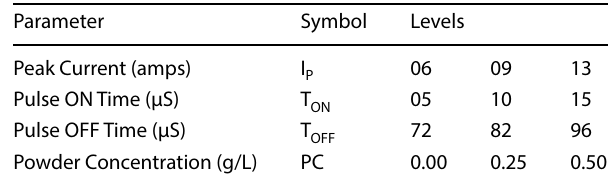
Table 3 Machining parameters and